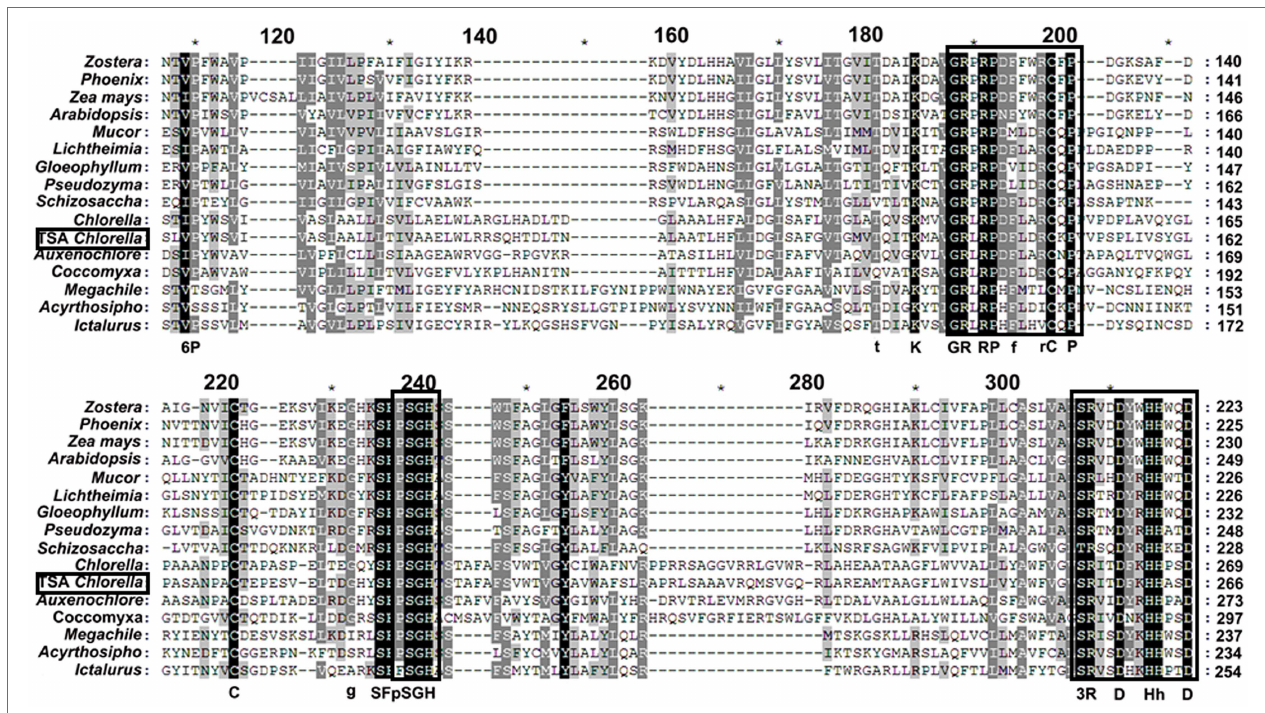
FIGURE 1 | Sequence alignment of the phosphatidate phosphatase (PAP) domains from tolerant saline-alkali (TSA) Chlorella ChPAP2 with those of other species. The conserved residues, including the KxxxxxxRP (domain 1), PSGH (domain 2), and SRxxxxxHxxxD (domain 3) motif, are indicated by boldface in boxes. The ChPAP2 sequence data have been deposited in the GenBank database and assigned accession no. KT750011. The other PAP protein sequences were downloaded from